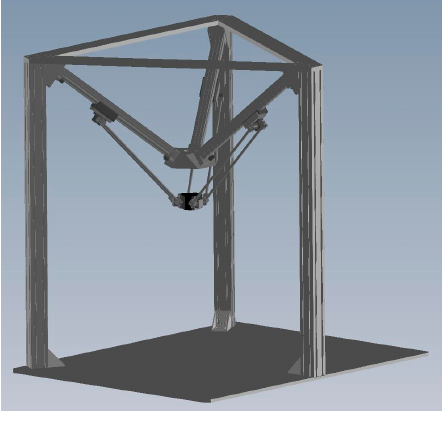
Figure 2. The structure of the 3-DOF parallel manipulator.